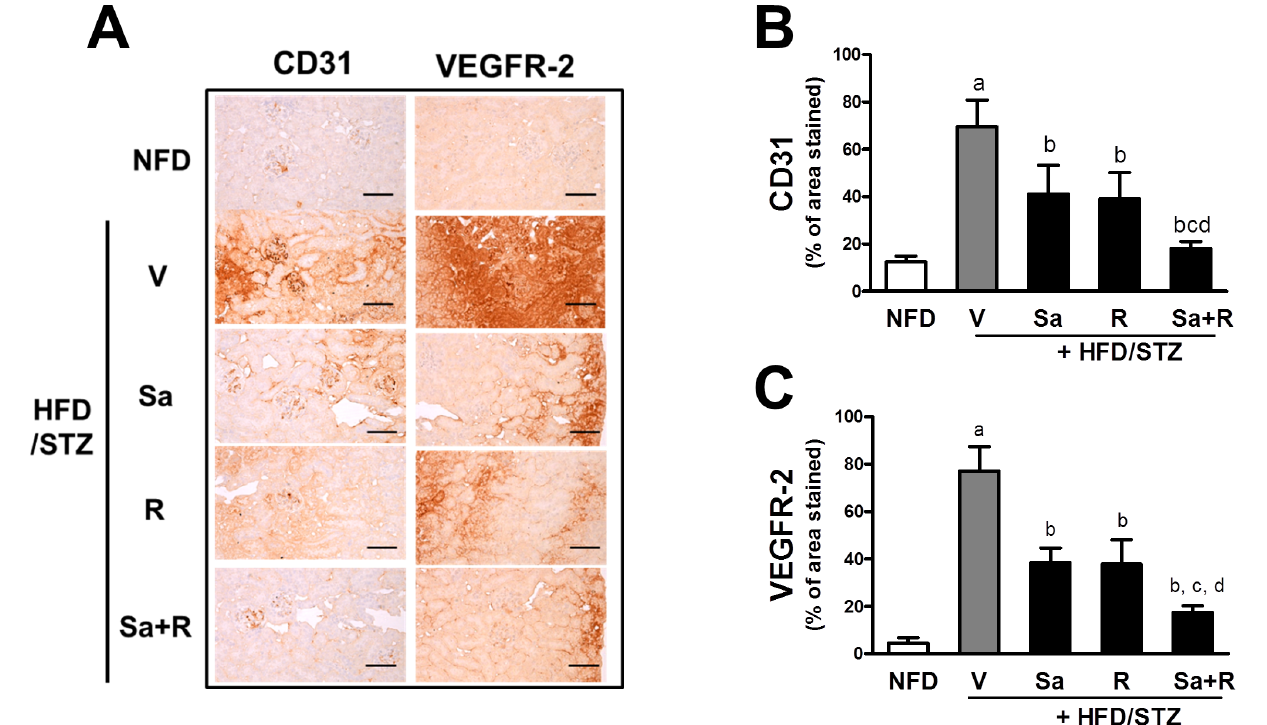
Fig 4. Amelioration effects of sarpogrelate and rosuvastatin on the expression of angiogenic markers CD31 and VEGFR-2. (A) Immunohistochemcial analyses were carried out with CD31- or VEGFR-2-specific antibodies and representative immunoreactive cortex regions are shown. (B-C) The CD31 (B) or VEGFR-2 (C)-positive cortex areas were quantified. a P < 0.05 compared with the NFD control group. b P < 0.05 compared with the HFD/STZ group. c P < 0.05 compared with the HFD/STZ + Sa group. d P < 0.05 compared with the HFD/STZ + R group. Two histological fields for each kidney tissue were analyzed. All data represent means ± SD. Scale bar = 120 μ